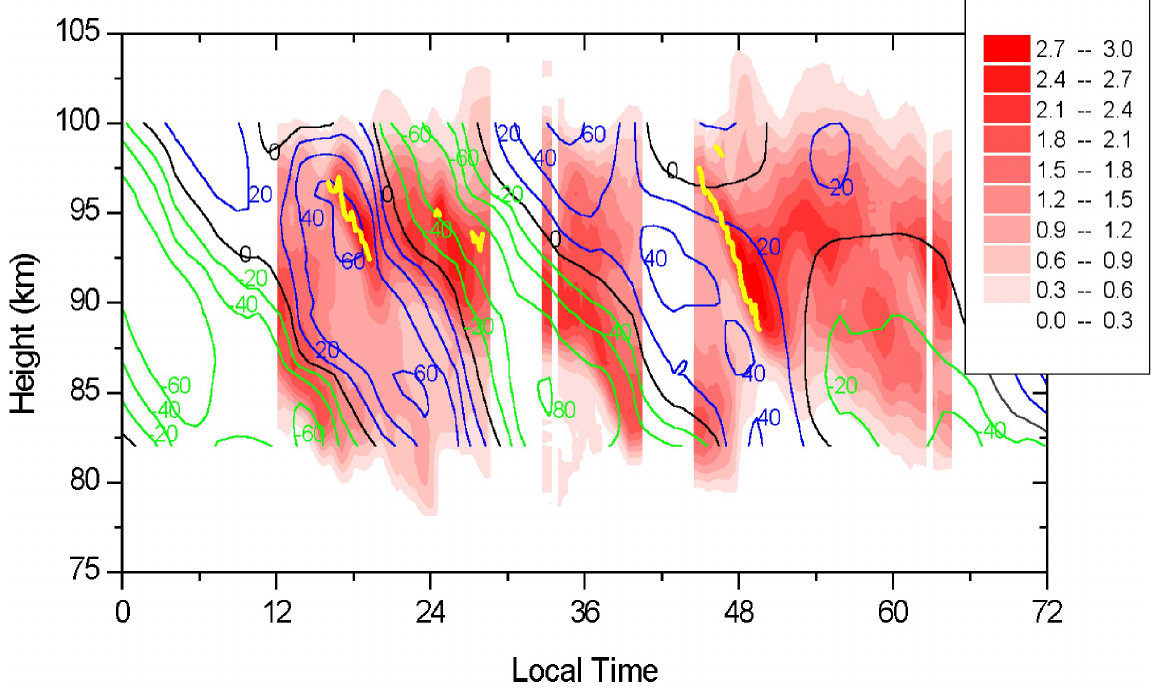
Fig. 5. Na density and meridional winds from 12:00 LT on 12 July to 16:36 LT on 14 July 1999. Density units are 109m − 3 . The yellow lines mark Ns-layers. Winds are shown in units of m, s − 1 : positive contours are shown in blue, negative in green, and the zero wind contour in black (after Clemesha et al., 2001).